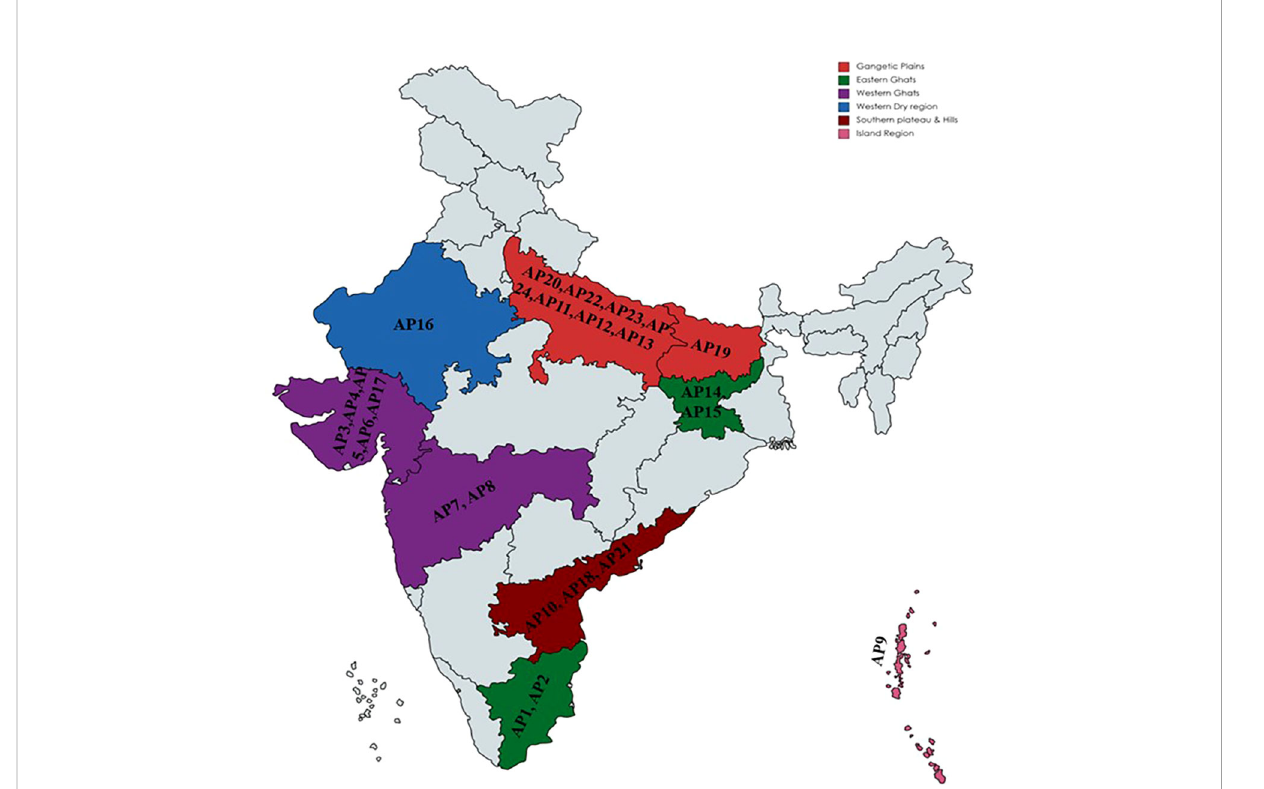
FIGURE 1 Geographical distribution of twenty-four kalmegh accessions used in the present